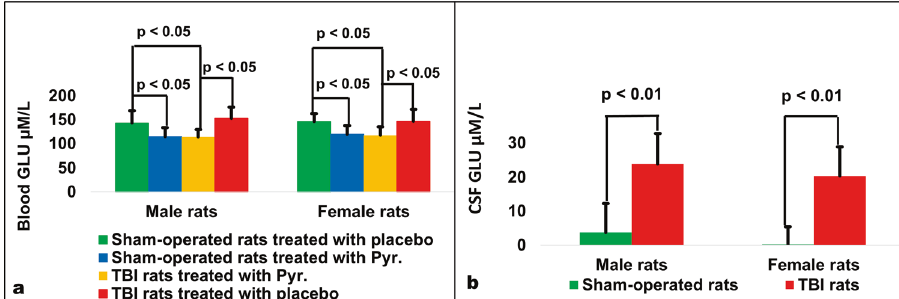
Fig. 2 Blood and CSF glutamate levels. Blood glutamate in experimental group for males and females ( a ), and CSF glutamate levels following TBI compared to sham-operated controls in male and female ( b ) rats. For both male and female rats, there was a signi fi cant decrease in blood glutamate for sham-operated rats treated with pyruvate compared to sham-operated rats treated with placebo and post-TBI rats treated with pyruvate compared to post-TBI rats treated with placebo. Compared to sham-operated rats, the concentrations of CSF glutamate 12 h after surgical intervention was signi fi cantly greater in male and female rats following TBI. CSF Cerebrospinal fl uid, GLU glutamate, Pyr Pyruvate, TBI Traumatic brain